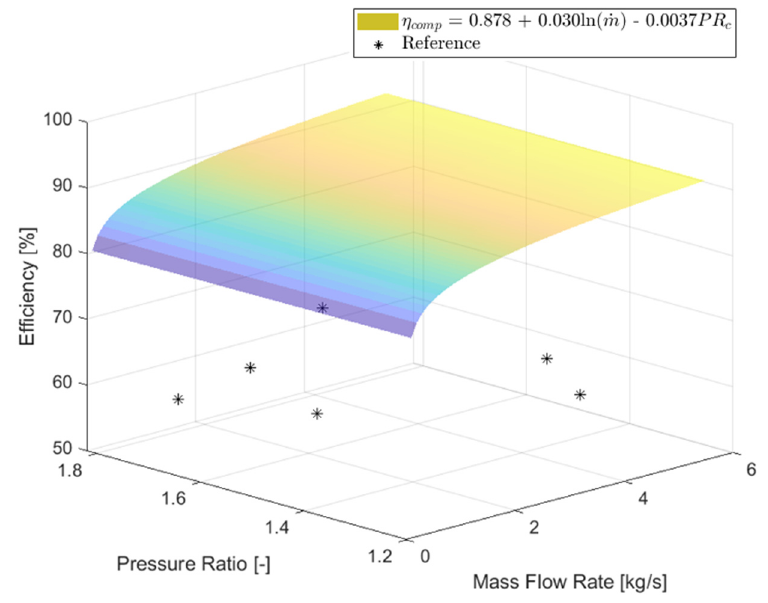
Figure 7. Comparison of compressor polytropic efficiency with S-CO 2 compressor experimental facility.